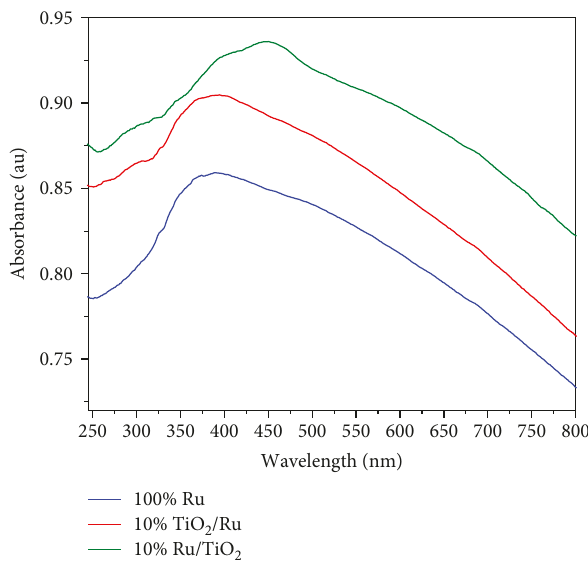
Figure 5: UV-Vis spectra of the